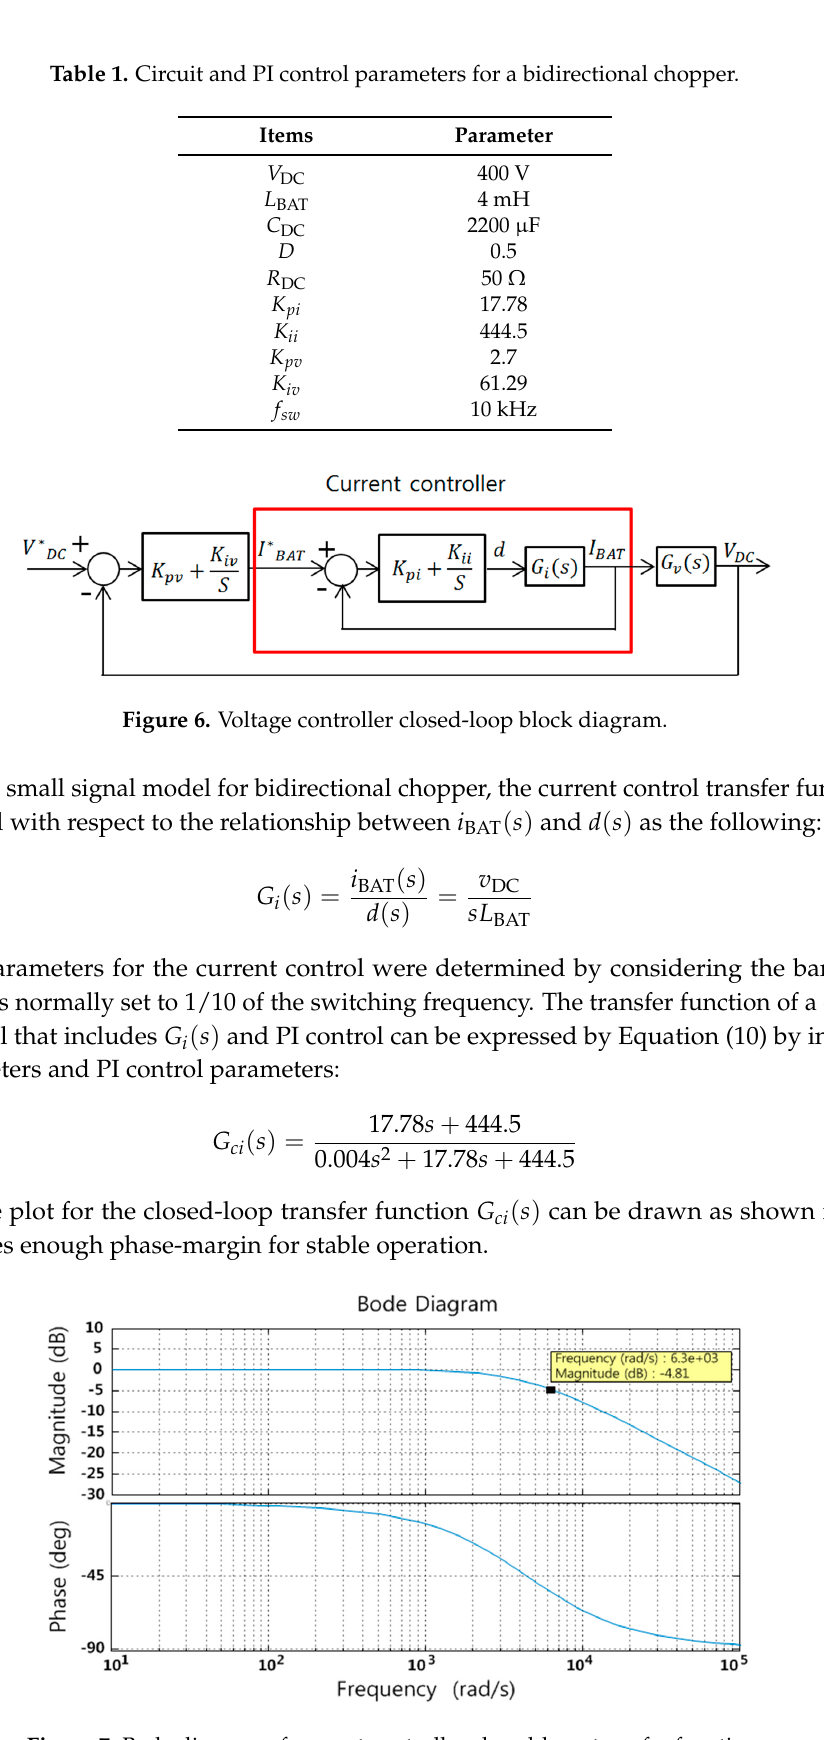
Figure 7. Bode diagram of current controller closed-loop transfer function.